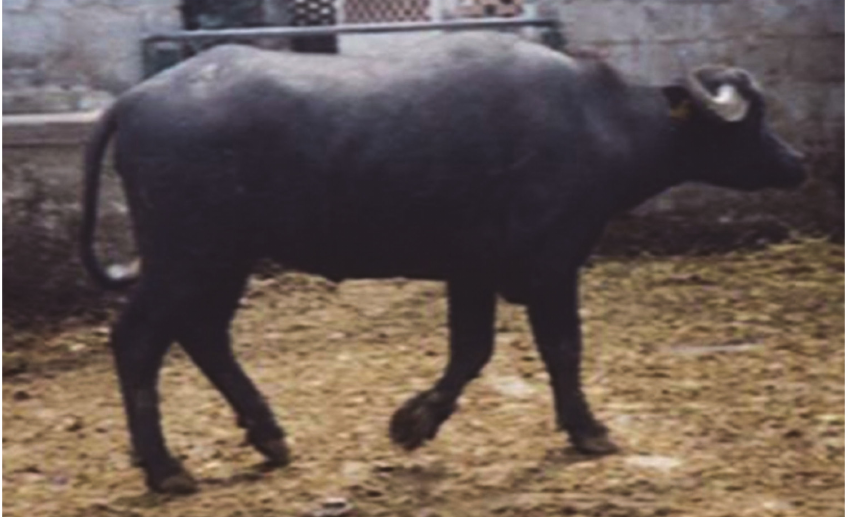
Figure 2. Female river buffalo, five years old, affected by X trisomy (2 n = 51, XXX). Note the prominent withers (male